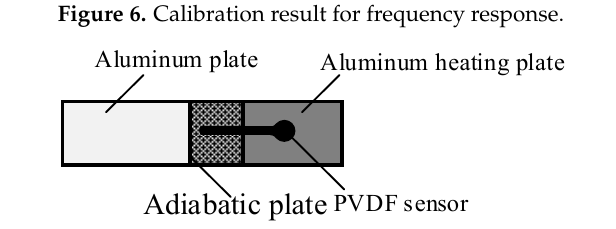
Sensors 2019 , 19 , x FOR PEER REVIEW Figure 7. Schematic diagram of the aluminum heating plate. Figure 7. Schematic diagram of the aluminum heating plate.